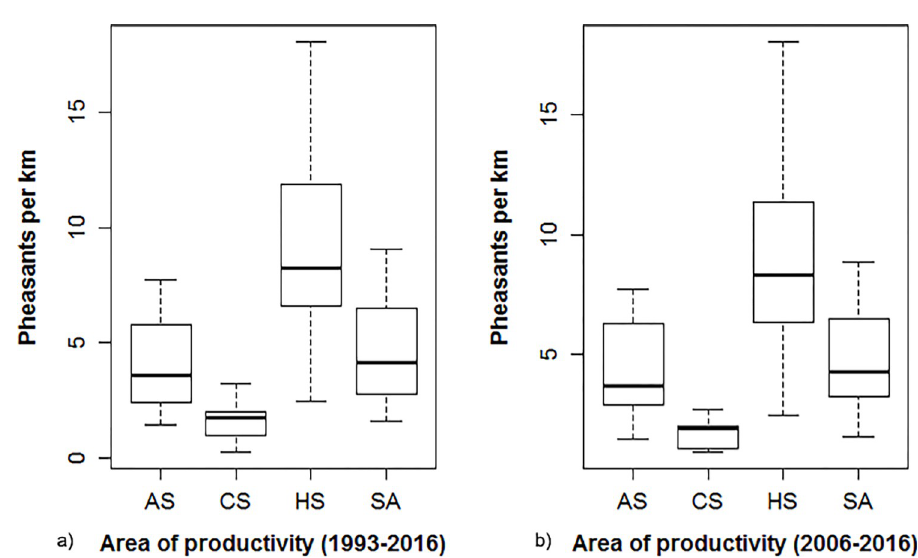
Fig 2. Boxplots of pheasants � km -1 over a) 24-year and b) 11-year period across the study area (SA), HotSpot (HS), ColdSpot (CS) and AverageSpot (AS).